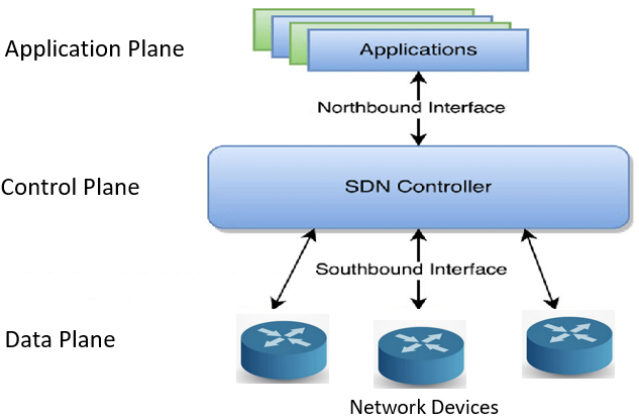
Figure 1. The three planes in the SDN